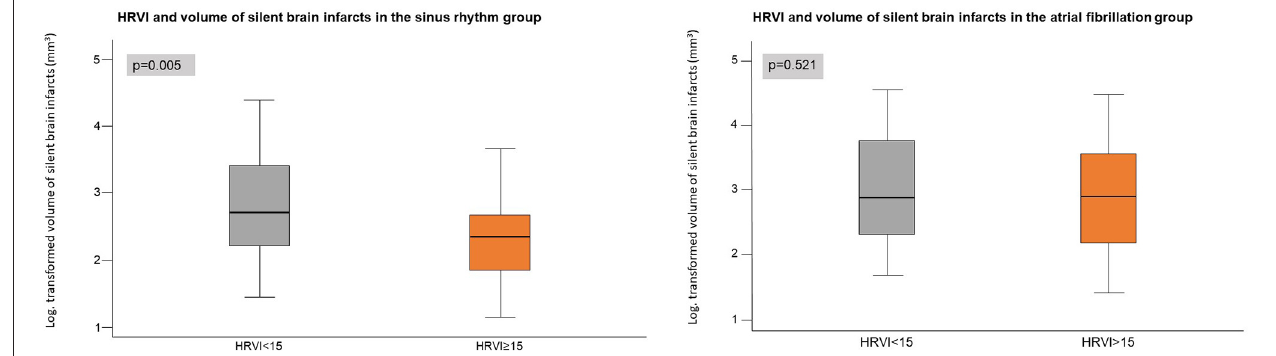
FIGURE 2 | Volumes of silent brain infarcts in the sinus rhythm group (left) and in the atrial fibrillation group ( right ,exploratory analysis) stratified by heart rate variability triangular index